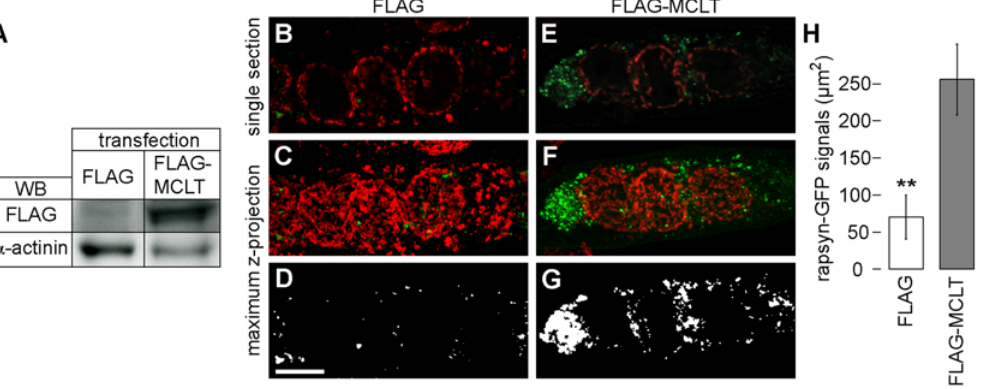
Figure 2. Rapsyn-GFP accumulates in the perinuclear regions of FLAG-MCLT expressing C2C12 myotubes. C2C12 myoblast cells were co-transfected with rapsyn-GFP and FLAG (FLAG) or FLAG-MCLT (FLAG-MCLT). Upon seven days of differentiation, cells were lysed (A) or fixed and immunostained for GM130 (B–H). A: Bands, western blot signals upon incubation with FLAG or alpha-actinin antibodies of lysates of cells transfected with FLAG or FLAG-MCLT (indicated). B, E: Optical sections of rapsyn-GFP (green) and GM130 (red). C, F: Maximum z-projections of the cells depicted in B and E. D, G: Binarised rapsyn-GFP signals from projections shown in C and F for quantification of rapsyn-GFP positive areas. Scale bar, 10 m m. H: Quantification of total rapsyn-GFP positive area per myotube on binarised maximum z-projections. Data, mean 6 s.e.m. (n=5